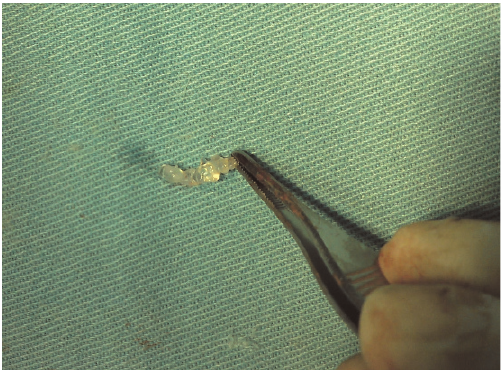
Figure 2 - Platelet gel before application to the chondral injury (source: personal file).